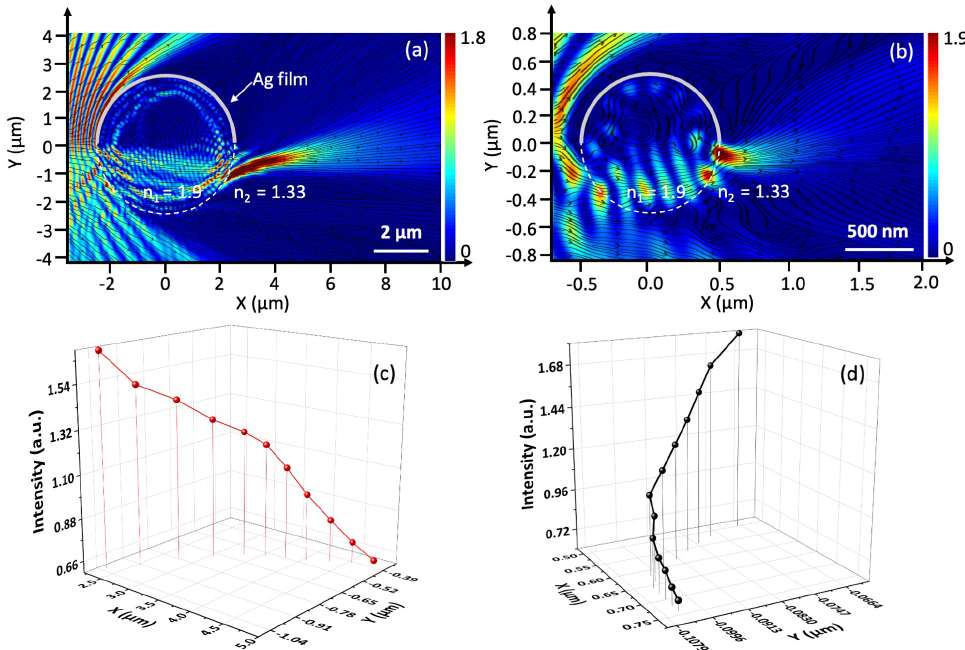
Figure 2. ( a ) Light field formed by a 5 µ m diameter patchy microcylinder. ( b ) Light field formed by a 1 µ m diameter patchy microcylinder. ( c , d ) Corresponding 3D trajectories of the midline of the light fields formed by ( c ) a 5 µ m diameter and ( b ) a 1 µ m diameter patchy